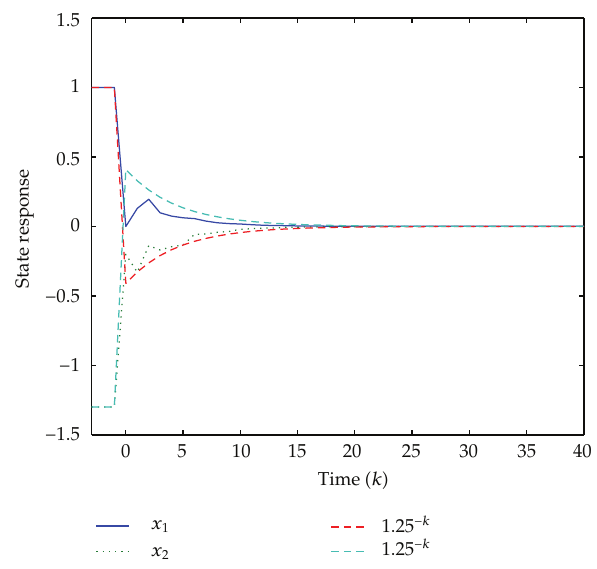
Figure 1: Simulation results of and as compared 1 . 25 − k .